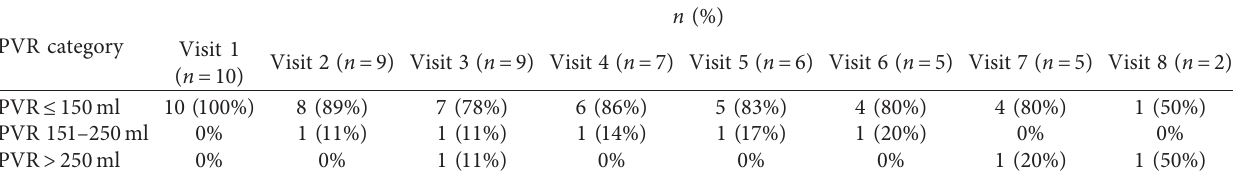
Table 6: PVR summary for patients in the Continuing Access Program.